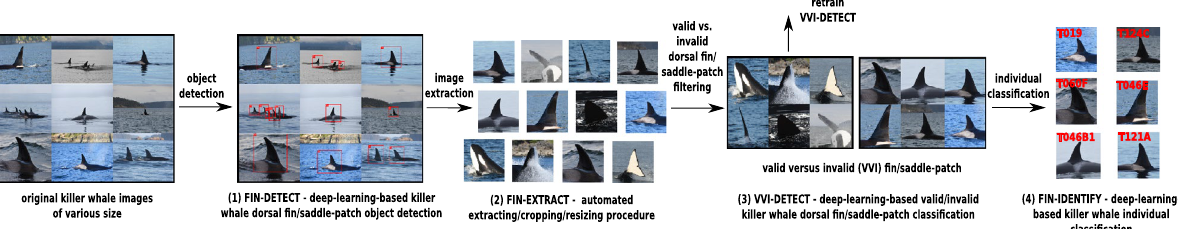
Figure 1. FIN-PRINT workflow including: (1) dorsal fin/saddle patch detection, (2) extraction of the detected killer whale markings, (3) valid versus invalid dorsal fin/saddle patch binary classification, and (4) multi-class killer whale individual